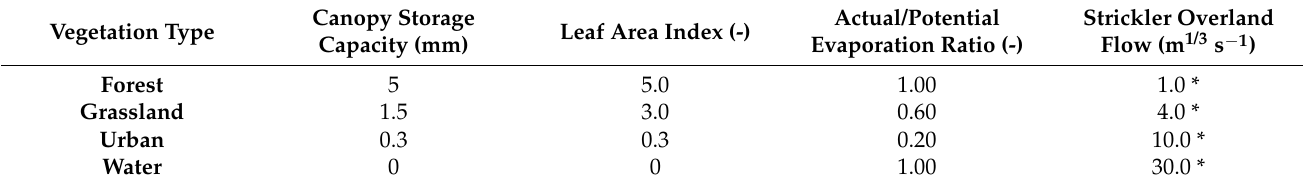
Table 2. Land-use parameters used in the model. * indicates a parameter was